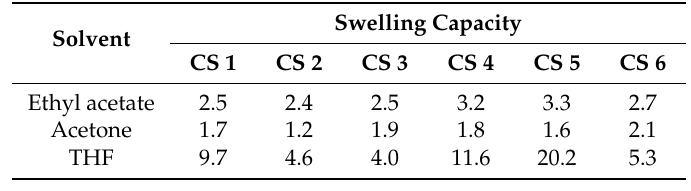
Table 1. Swelling capacity of CSs 1 – 6 in organic solvents.